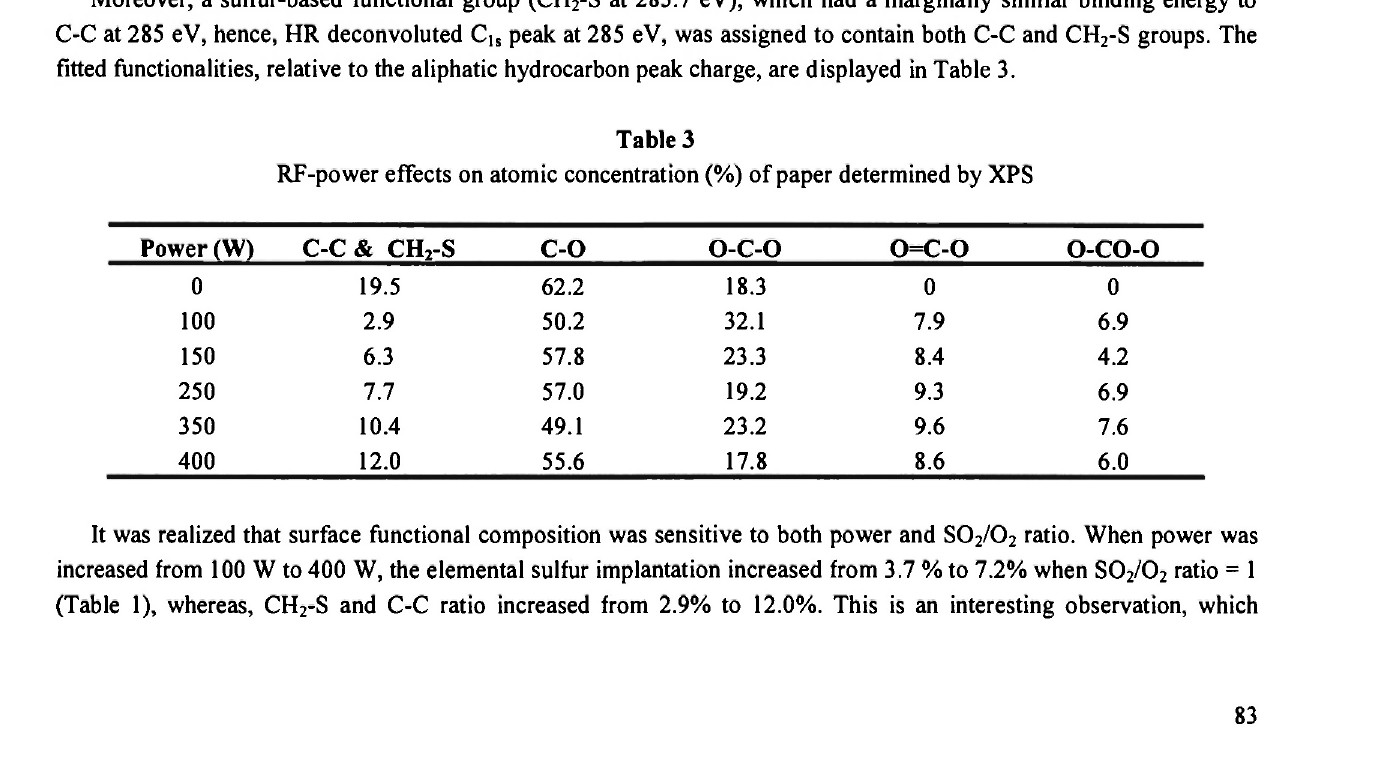
Fig. 4: Comparative HR Ci s XPS spectrum of S0 2 +0 2 RF plasma treated paper